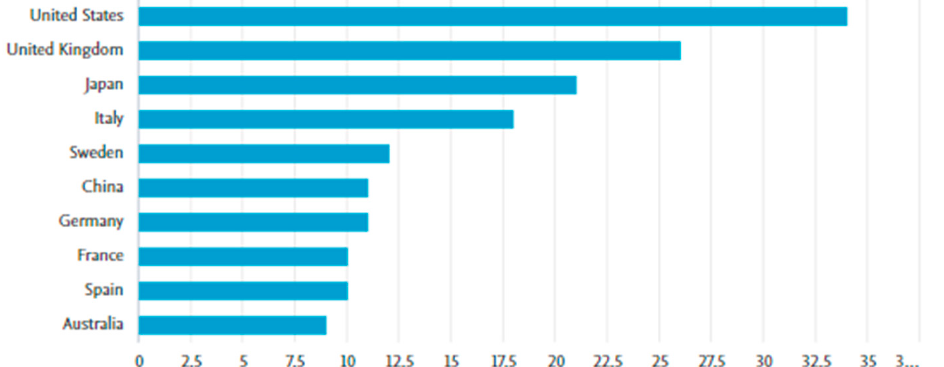
Figure 8. Countries with the highest number of publications—Scopus.